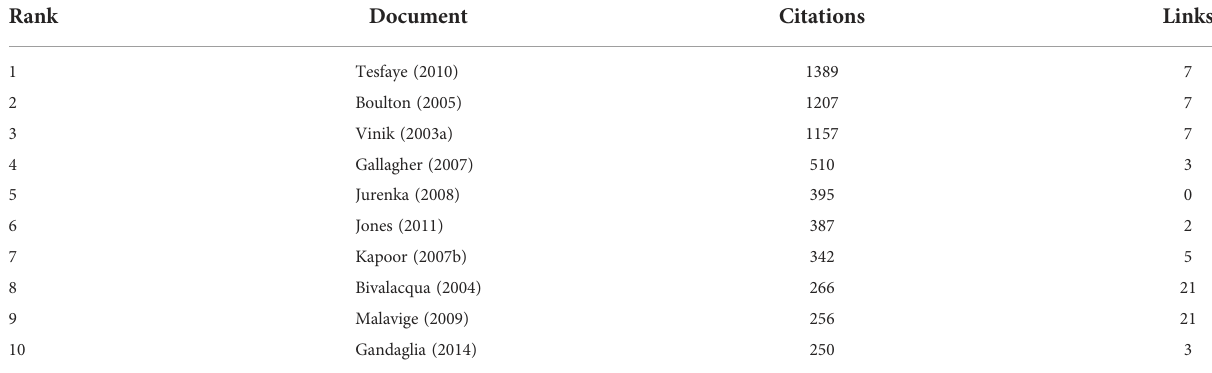
TABLE 9 The number of citations for the top 10 references.